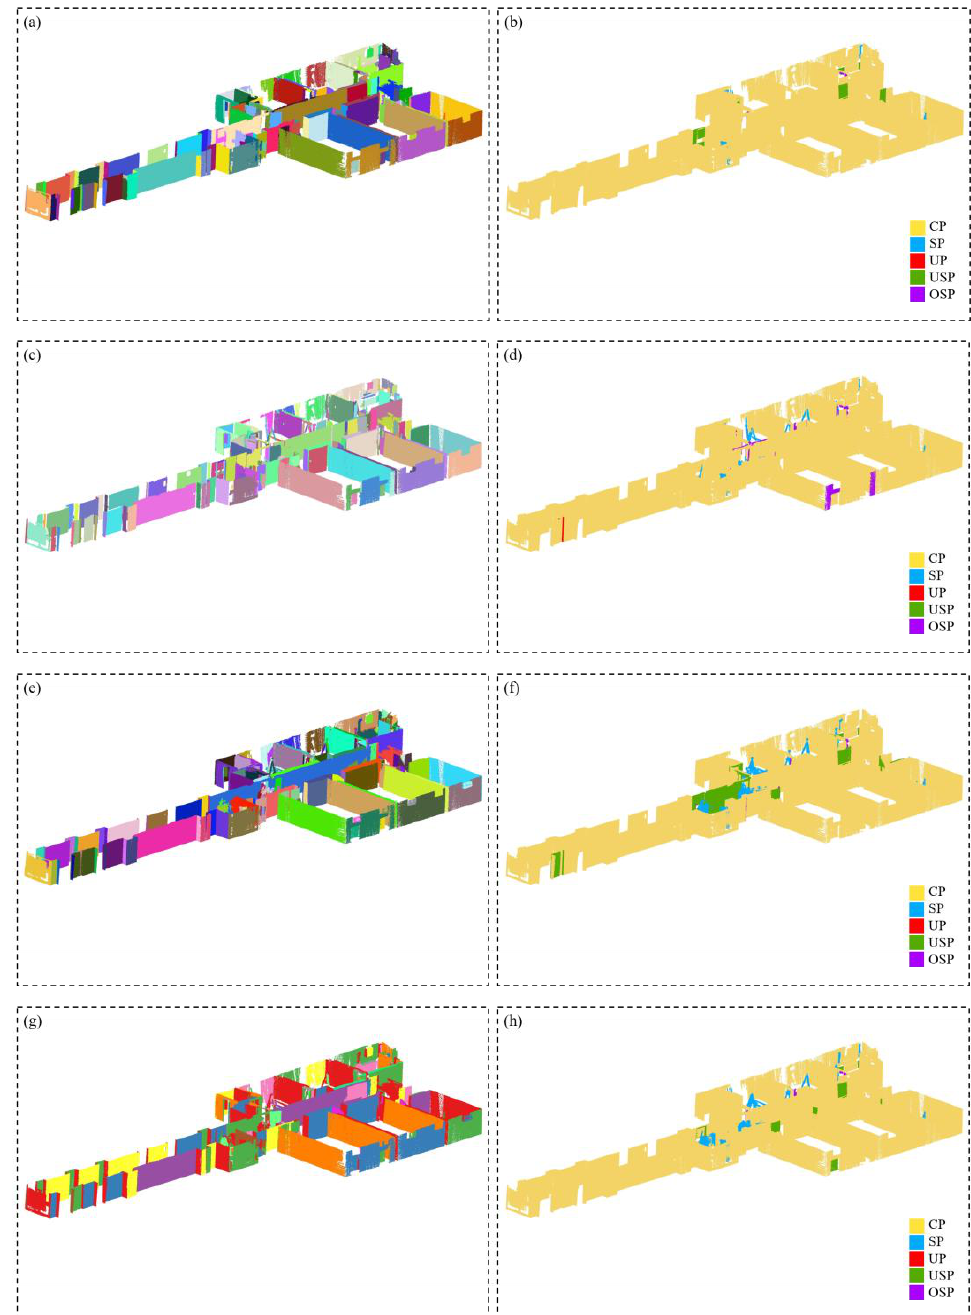
Figure 17. Comparison of plane-segmentation results for the TUB1 dataset: ( a , b ) proposed method and the main differences from ground truth, ( c , d ) RG and the main differences from ground truth, ( e , f ) efficient RANSAC and the main differences from ground truth, and ( g , h ) G-L 0 and the main differences from ground truth.